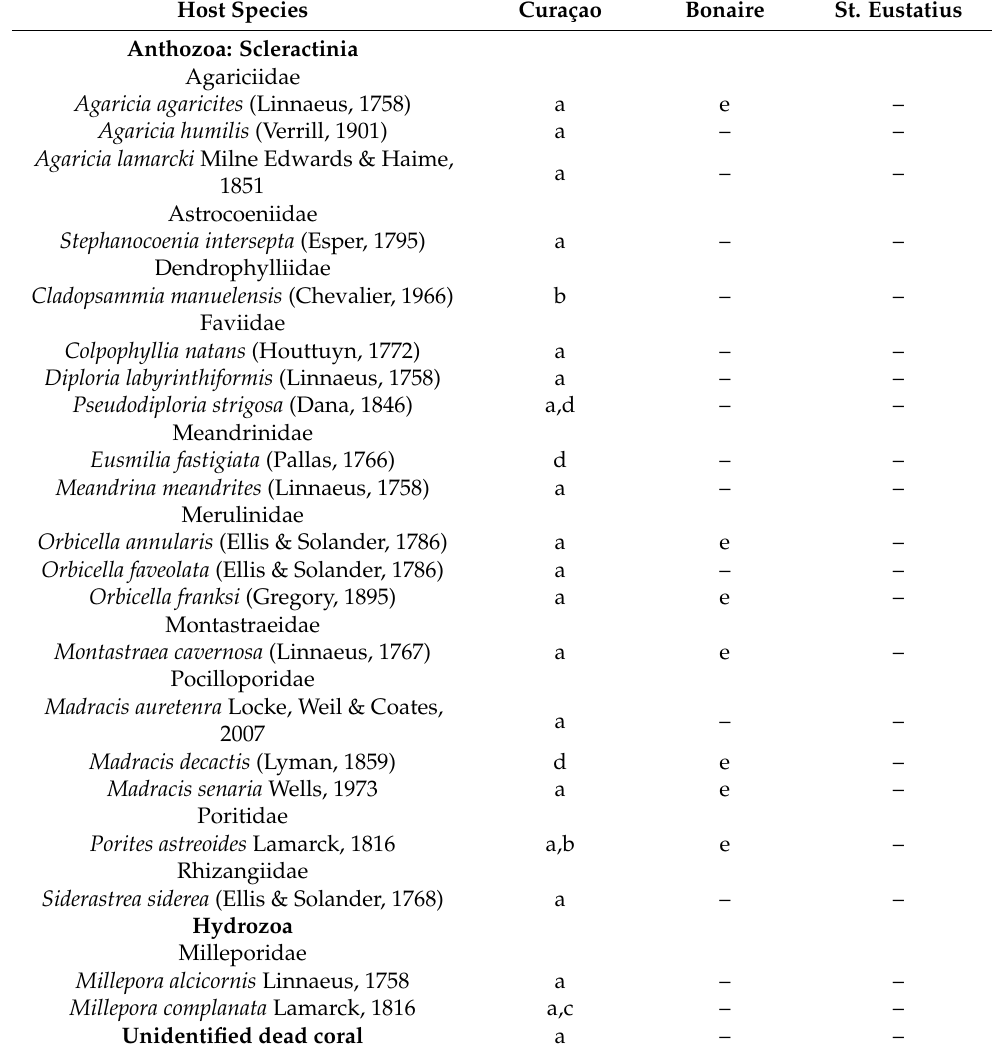
Table 1. Records of stony corals as host species (by family) for the vermetid gastropod Petaloconchus sp. based on photographs made at Curaçao (a: 2021; b: 2017; c: 2015; d: 2014), Bonaire (e: 2019), and St. Eustatius